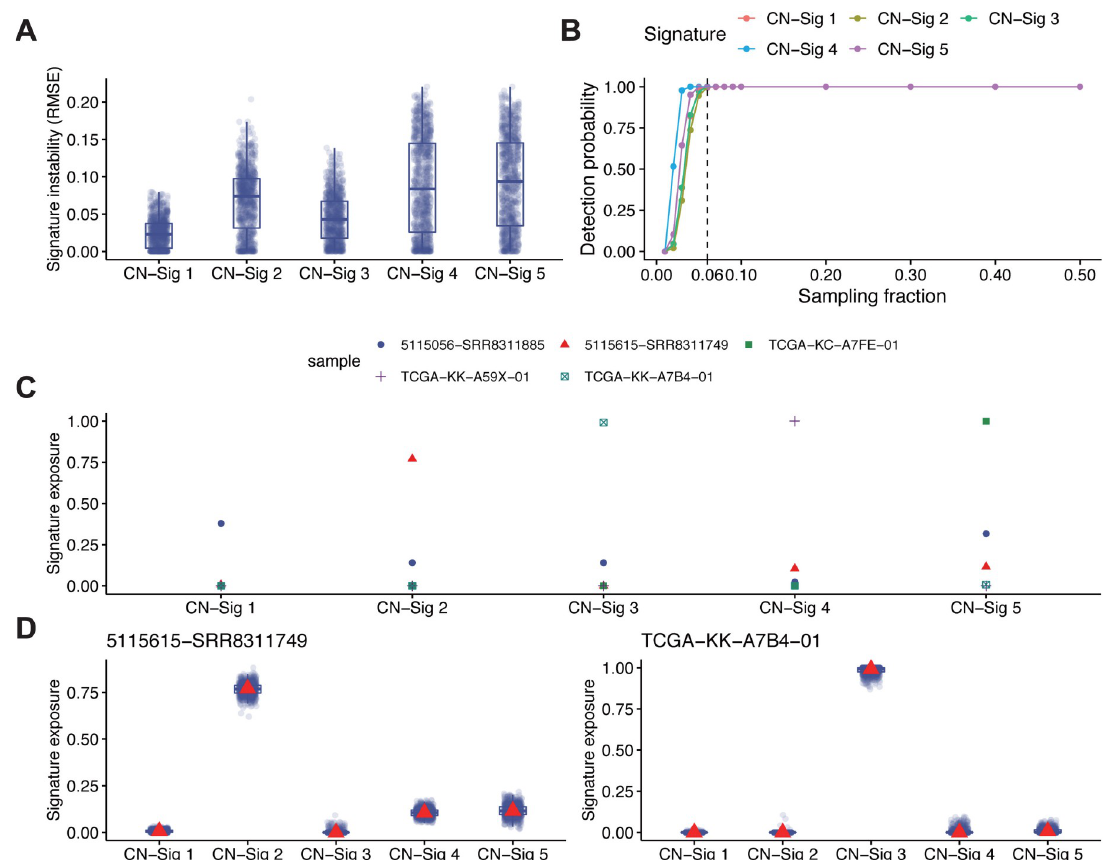
Fig 3. Signature instability analysis and single sample copy number signature analysis. (A) Comparison of signature exposure instability measured as RMSE (root mean squared error) between exposures in 1000 bootstrap mutation catalogs and exposures in the original mutation catalog for each tumor. (B) Signature detection probability versus different sampling fraction. The dotted line indicates we could steadily detect all five copy number signatures with at least 6% (~57) tumors. A signature is detected if more than 10 tumors have at least 1% relative exposure under p-value cutoff 0.05. The sampling process was repeated 1000 times for each sampling fraction to estimate the detection probability. (C) Relative signature exposures measured through single sample signature fitting for the five tumors in Fig 2B. (D) Single sample signature instability analysis for two of the five tumors in Fig 2B based on 1000 bootstrap signature exposures (indicated as blue dots and boxplot) and the original signature exposure (indicated as red triangle). The boxplot is bounded by the first and third quartile with a horizontal line at the